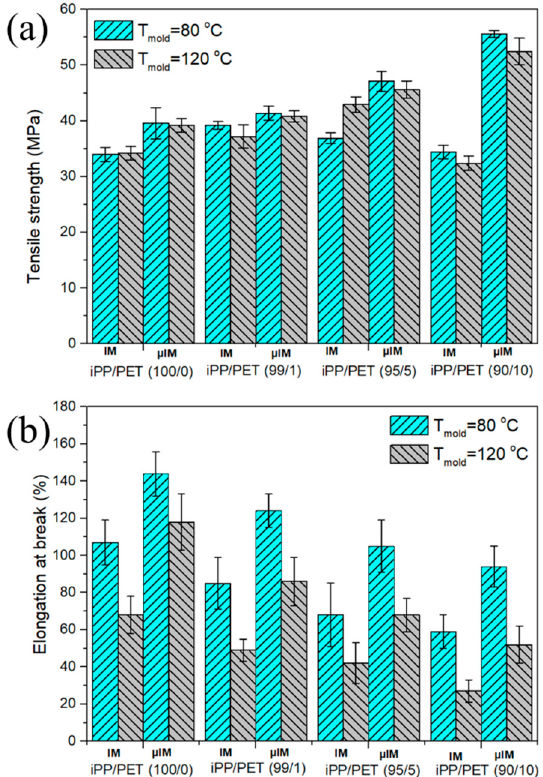
Figure 14. The tensile strength ( a ) and elongation at break ( b ) between M-parts and C-parts.